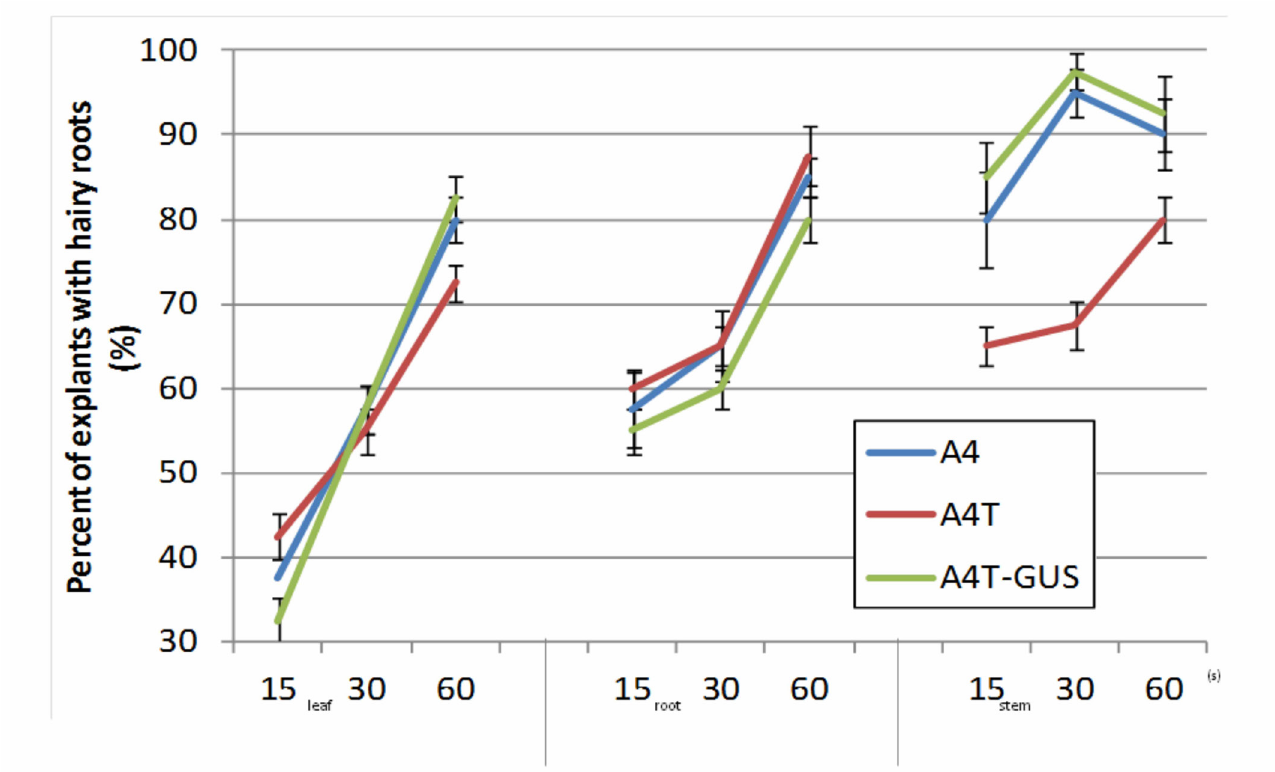
FIGURE 4 - Effect of sonication time on the percentage of H. sinaicum explants developing hairy roots depending on the explant type and A. rhizogenes strain used. Whiskers - standard